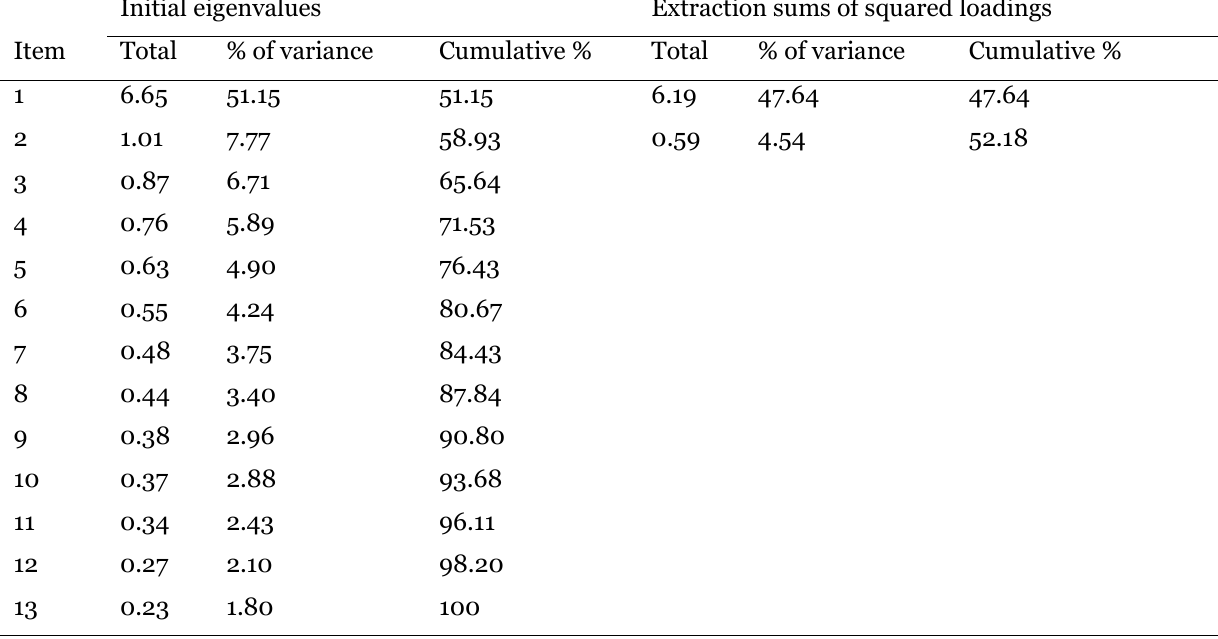
Total Variance Explained for the EFMC-MOOC